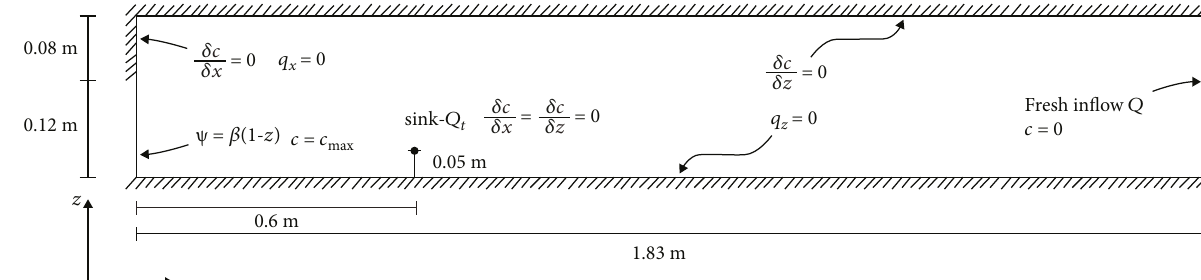
Figure 2: Conceptual model showing the boundary conditions used for numerical